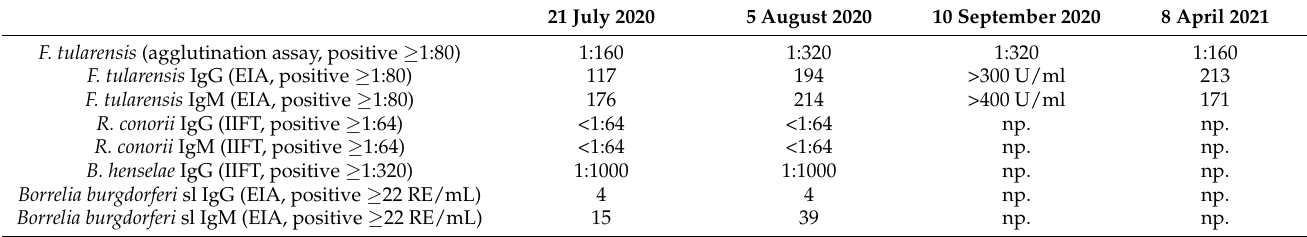
Table 1. Serologic test results of the patient with ulceroglandular tularaemia after the tick bite at the end of June 2020.